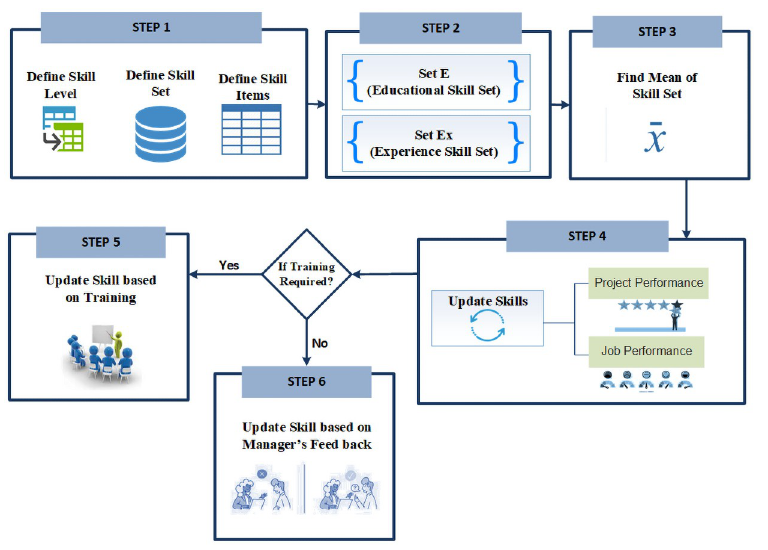
Fig 4. Skills calculation